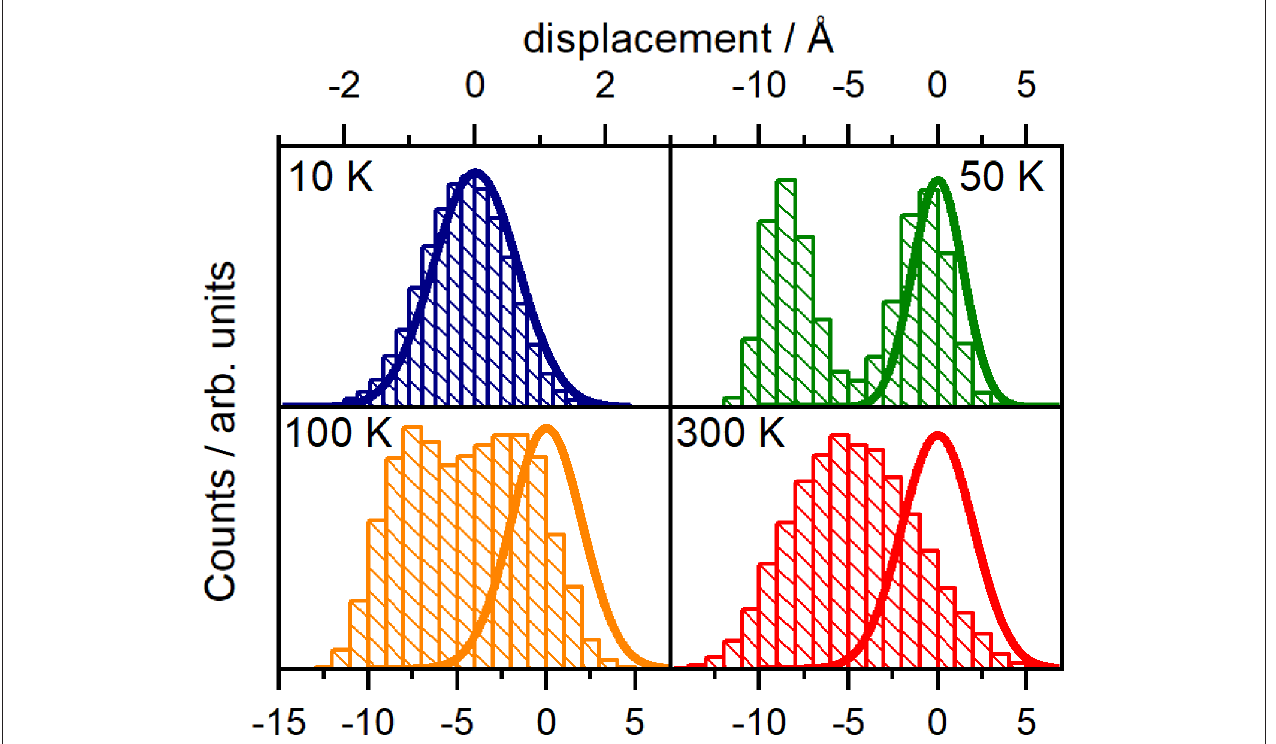
FIGURE 5 | Normal mode displacement probability distribution for selected an harmonic normal mode 3 of the orthogonal dyad. Statistics are derived from 20,000 configurations over 800 ps MD trajectories. Thick lines correspond to a displacement according to a harmonic approximation, adopted in normal mode